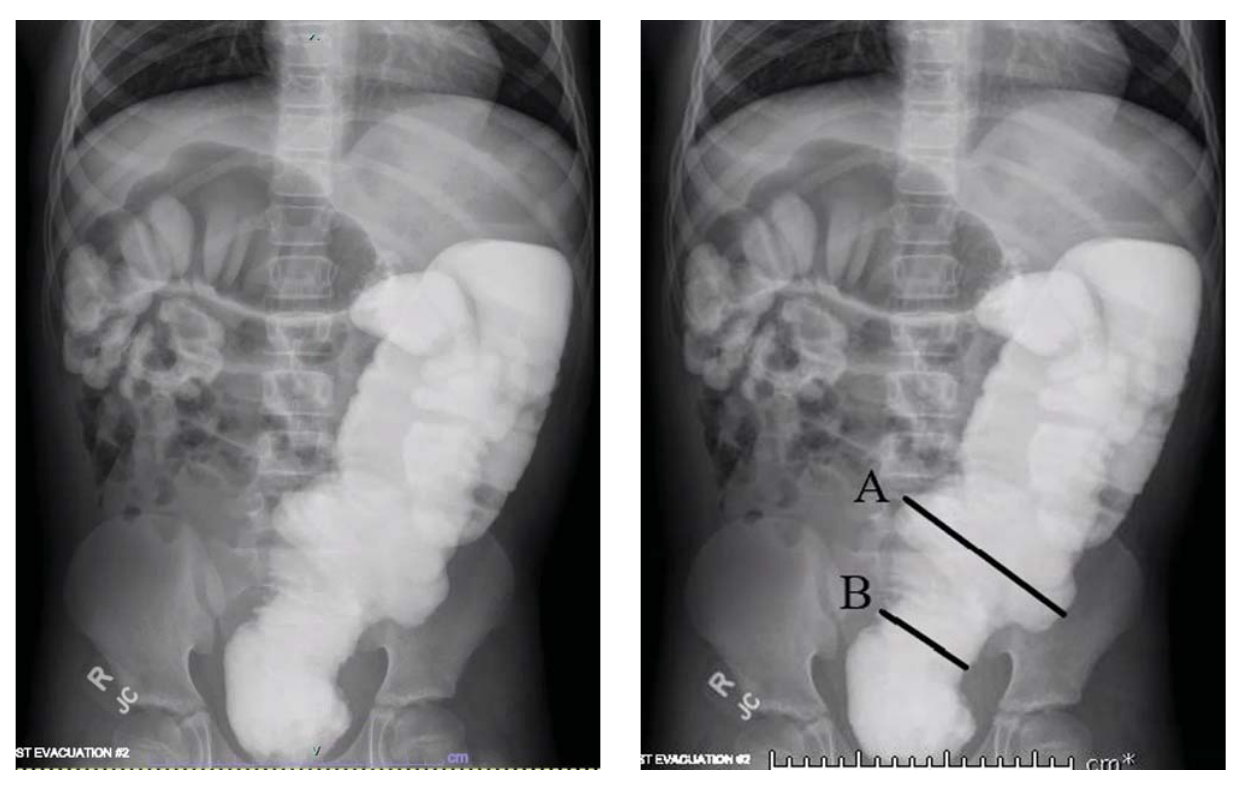
Fig. 1 Contrast enema study. Fig.2 Contrast enemastudy withdemonstrationof transitionzoneat rectosigmoid junction. ( A ) Sigmoid colon. ( B ) Rectosigmoid junction and transition